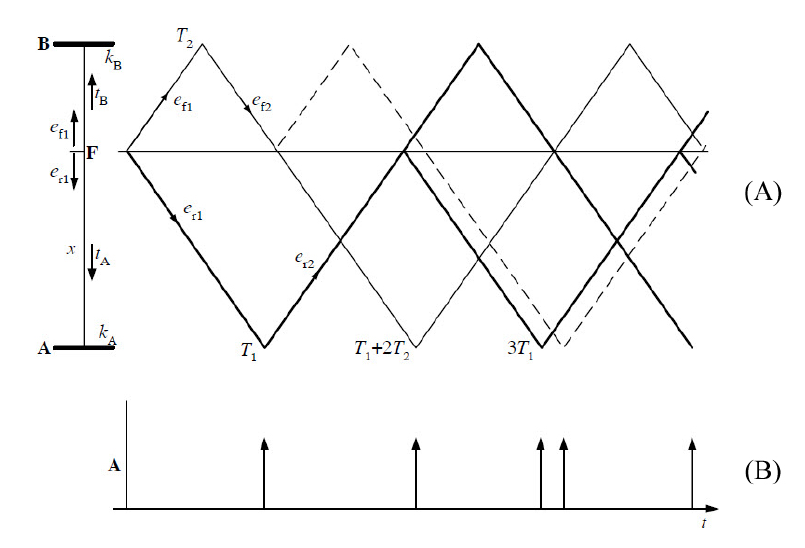
Figure 1. Lattice diagram [30]. ( a ) Traveling wave (TW) behavior. ( b ) Defined TW times in Terminal